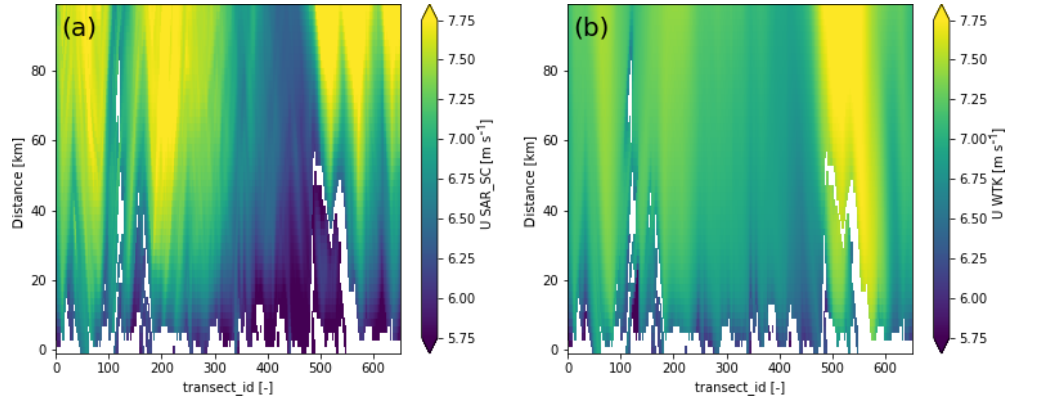
Figure 10. Mean wind speeds at 10ma.s.l. (above sea level) for all transects as a function of the distance to shore. (a) SAR_SC; (b) WTK.